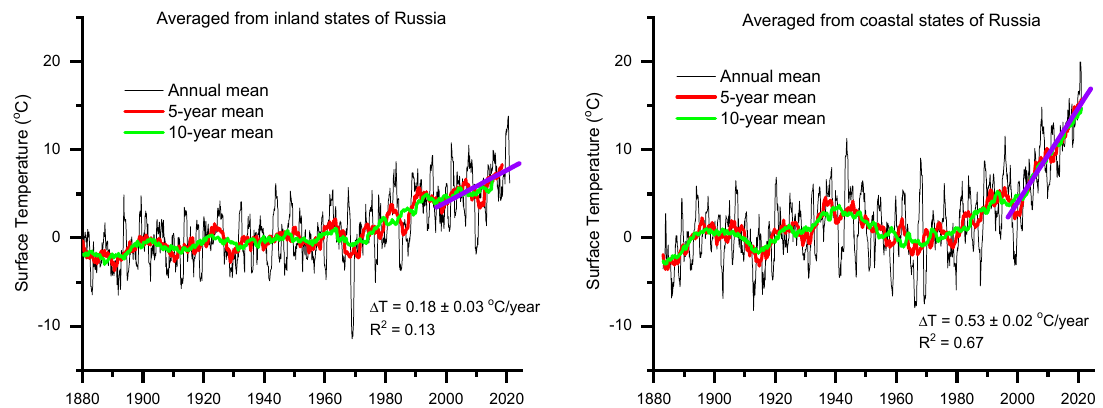
Figure 5. ( Upper panel ) Time-series annual surface temperatures of three representative inland states (Aga Buryat, Altay and Yevrey) that have no sea-ice melting versus three representative coastal states or observation stations (Sakha, Taymyr and Koryak) in which sea-ice melting occurs in Russia (the red lines roughly showing the change trends). ( Lower panel ) Time-series annual, 5-year and 10-year mean surface temperatures averaged from the 39 inland states or stations with no sea-ice melting versus the 12 coastal states or stations in which sea-ice melting occurs in Russia (see the text), where linear fits to the observed data after 2000 are given (the violet lines), with the slopes ∆ Ts (changed temperatures per year) and the R 2 (COD) values indicated.